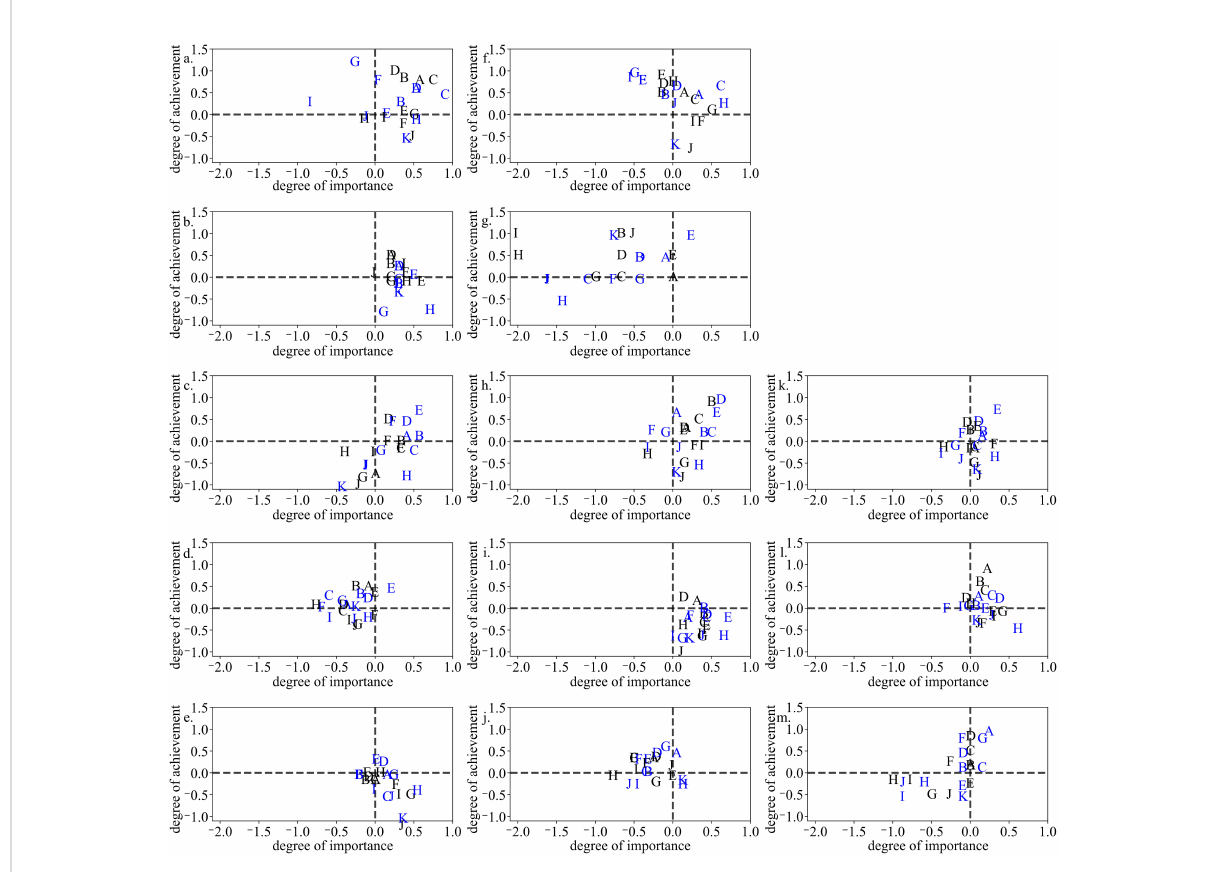
FIGURE 7 Relative comparisons of importance and achievement perceived by the respondent. The alphabets plotted in each fi gure are the relative importance and achievement, which is the difference of mean between each attribute and all, for the 10 questions ( A through I , questions common to Tables 2, 3). Comparisons performed for each of the organizations (left column), ages (center column), and the number of years are presented (light column). Organizations are university and research institutes (A) , ministries and government of fi ces (B) , prefectures (C) , local governments (D) , others (E) . Ages are less than 25 (F) , 25 to 34 (G) , 35 to 44 (H) , 45 to 54 (I) , and more than 55(j). The number of years are less than 1 (K) , 1 to 3 (L) , and more than